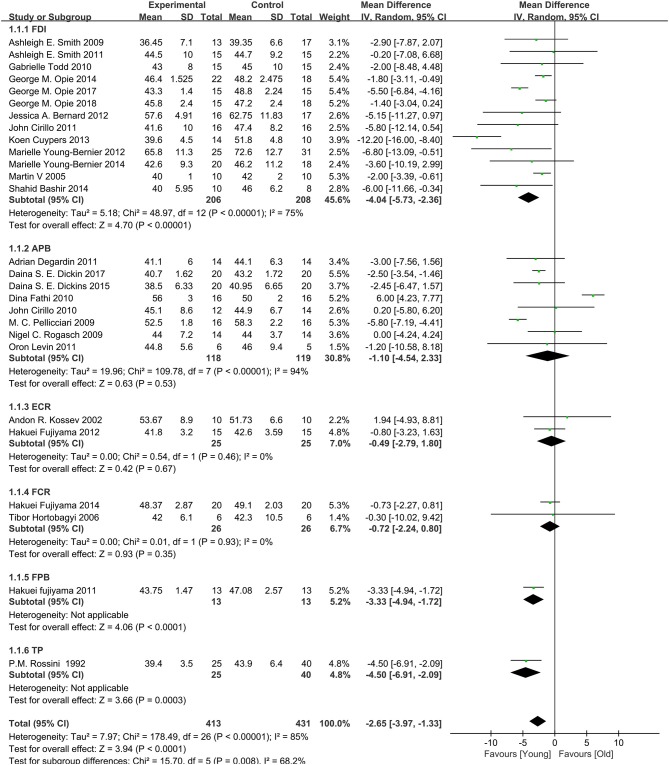
Young group vs. old group, RMT.